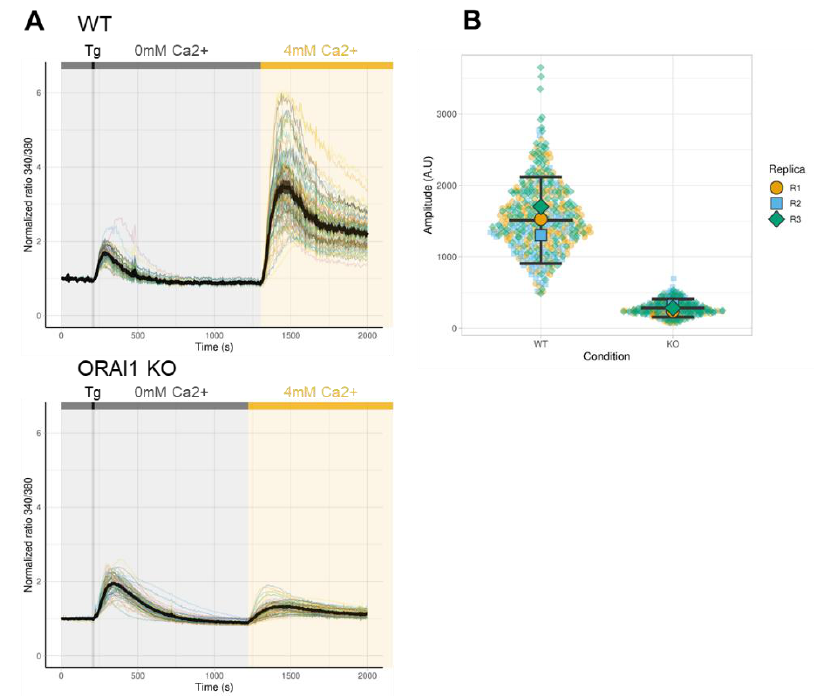
Figure 3. ORAI1 knockout (KO) reduces store-operated calcium entry (SOCE). ( A ) Representative traces of a single Ca 2+ imaging experiment. For both panels, all recorded cells are represented with different colored lanes, the mean value is presented in black, and the 95% confidence interval (CI) is shown in grey. Each experiment was repeated at least three times. ORAI1 KO cells exhibit a greatly reduced SOCE compared with wild-type (WT) cells. ( B ) The integrated area of the curve following Ca 2+ addition representing SOCE. Values from each individual cells from three independ- ent experiments are displayed in semitransparent colors (replicate N°1 yellow circles, replicate N°2 blue squares, and replicate N°3 green diamonds). For each experiment, the median values are dis- played in plain shapes (replicate N°1 yellow circles, replicate N°2 blue squares, and replicate N°3 green diamonds). Data generated for each experiment were considered nonpaired. Black bars rep- resent the mean and the 95% CI of the three independent experiments. The difference in SOCE be- tween WT HEK-293 cells (mean = 1511 with a 95% CI of 906 – 2117) compared with ORAI1 KO HEK- 293 cells (mean = 282 with a 95% CI of 154 –411) was assessed by Welch’s t -test and was significant ( p = 0.007). 3.3. Effect of ORAI1 KO on the Expression of ORAI2 and ORAI3 The three ORAI proteins (ORAI1, ORAI2, and ORAI3) are able to generate Ca 2+ entry [33]. In addition to ORAI1, HEK-293 cells also endogenously express ORAI2 and ORAI3. Thus, the remaining SOCE observed in ORAI1 KO cells could be attributed to Ca 2+ influx through ORAI2- and/or ORAI3-formed plasmalemmal channels. To check whether the deletion of ORAI1 led to compensatory overexpression of ORAI2 and ORAI3, we com- pared their mRNA expression levels in WT and ORAI1 KO HEK-293 cells. Our results indicate that both ORAI2 and ORAI3 are downregulated (Figure 4). Interestingly, two publications using triple KO in HEK-293 ( ORAI1 , 2 , and 3 ) showed that after overexpres- sion of ORAI2 and ORAI3 SOCE was restored in small proportion [34,35]. These results, together with the fact that ORAI2 and ORAI3 could form homomeric channels only in an overexpression system [33] (native currents provided through channels formed exclu- sively from endogenous ORAI2 or ORAI3 proteins were not reported yet), suggest that the residual Ca 2+ entry observed in our cells is unlikely due to overexpression of ORAI2 or ORAI3. This is corroborated by the results from Yoast et al. [35], who performed patch-